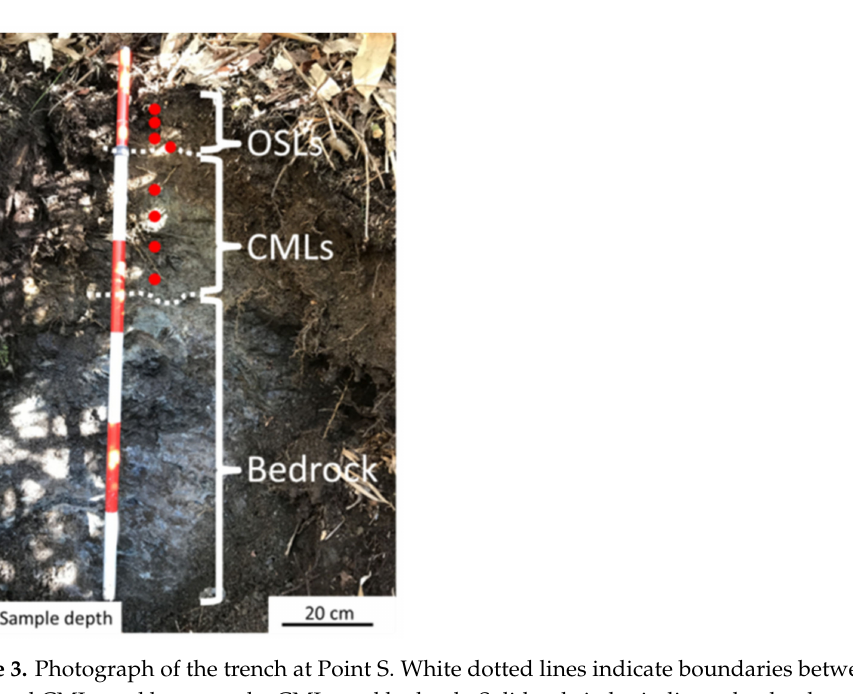
Figure 2. Flowchart of methodology of this study.